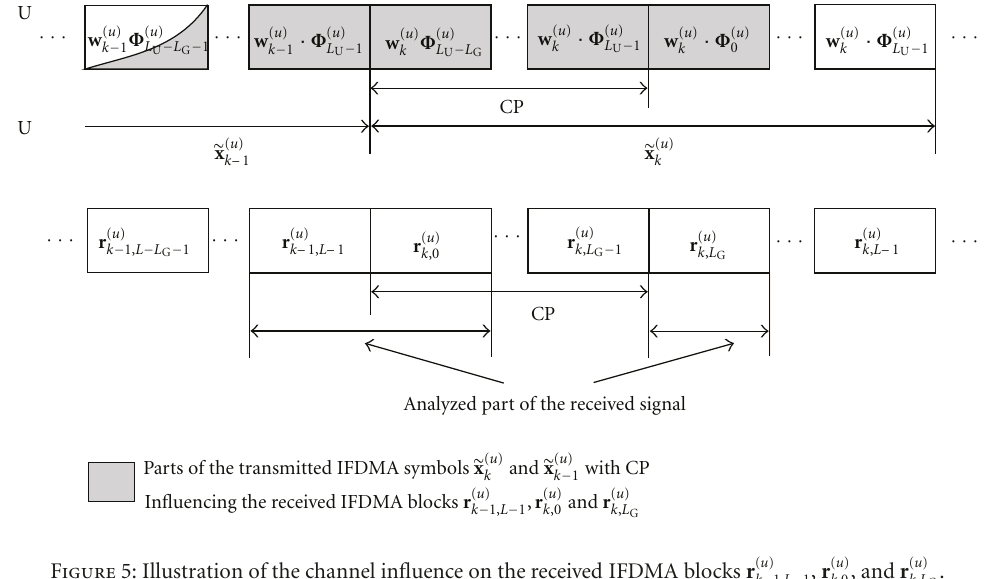
Figure 5: Illustration of the channel influence on the received IFDMA blocks r ( u ) k −